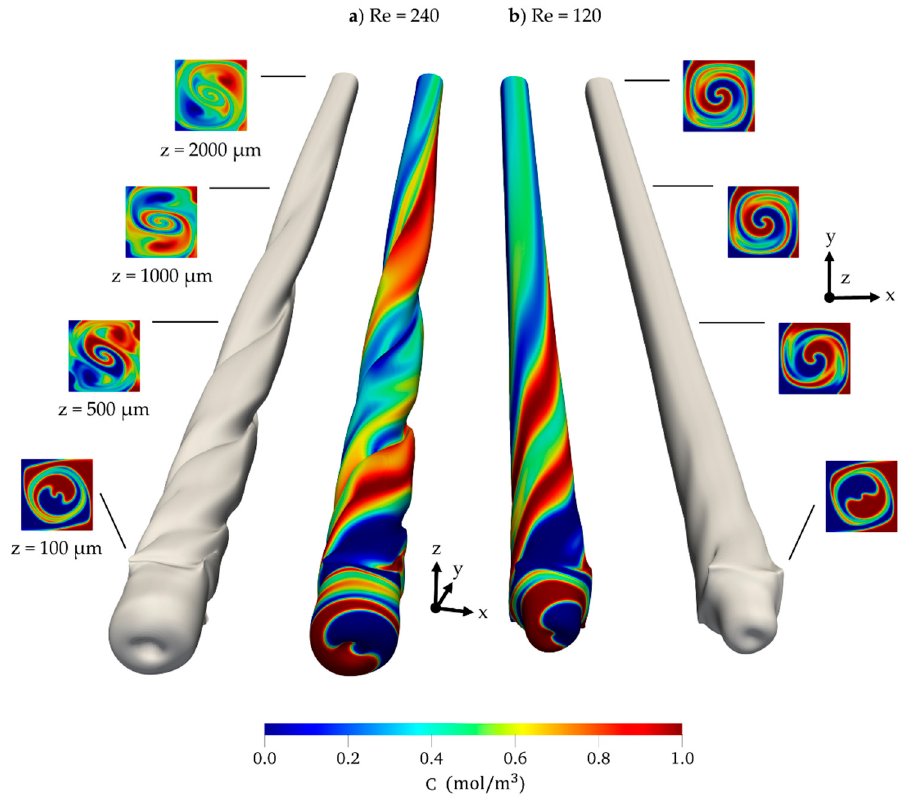
Figure 11. Fluid flow and scalar transport in the mixing channel of two-inlet design: ( a ) Re = 240 (left two shapes) and ( b ) Re = 120 (right two shapes). Colored images show scalar transport at M1 mesh level.